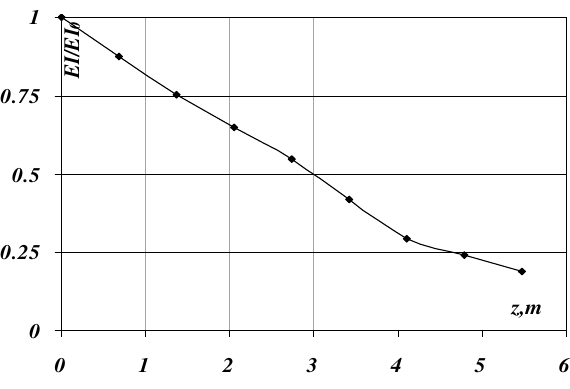
Fig 2. The beam has elastic support 1 and mass 2 also has the same kind of connection with the beam; 3 is the vibrator In figure 3, relative distribution of bending stiffness is shown. If it is accepted that the beam and additional weight have absolutely rigid constraints, then the relative distribution of weight among the nodes is in table. The weight of the beam itself, the attached weight in the middle zone of the beam, and the weight of the vibrator is common weight of dynamic system.